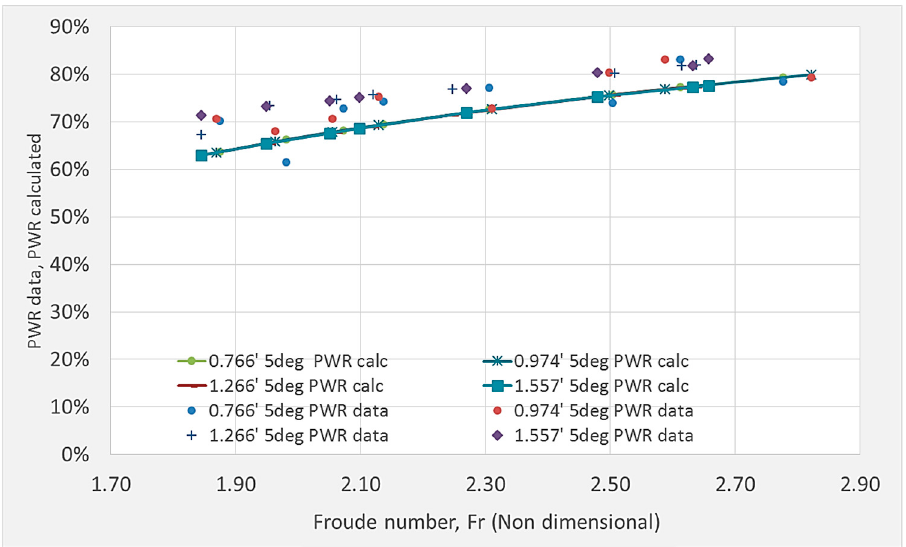
◦ pitch angle. Fluids 2019 , 4 , x FOR PEER REVIEW